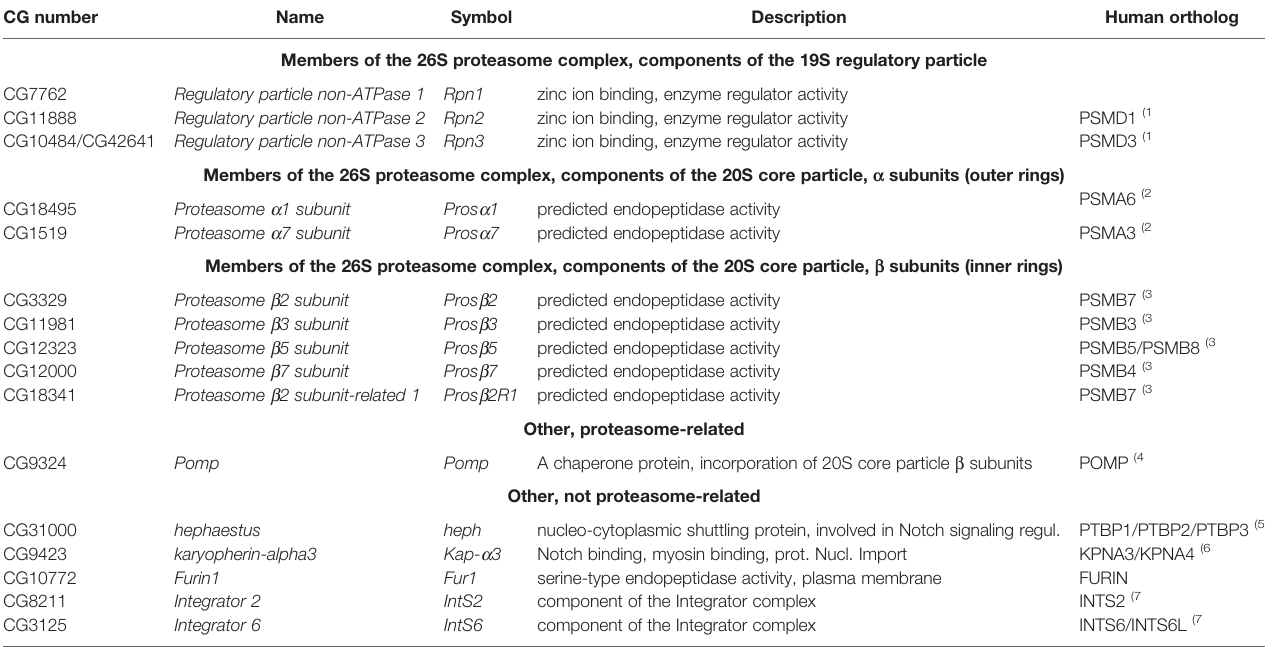
TABLE 2 | JAK/STAT pathway negative regulators from the genome-wide RNAi screen (cut off FC = 10), grouped by